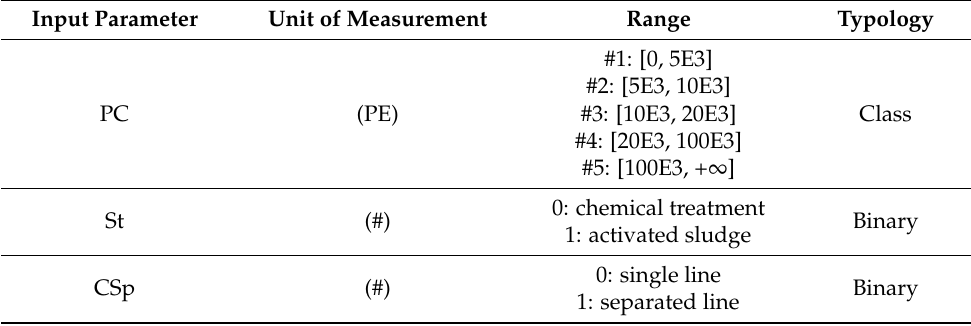
Table 7. List of the input parameters of the ANN